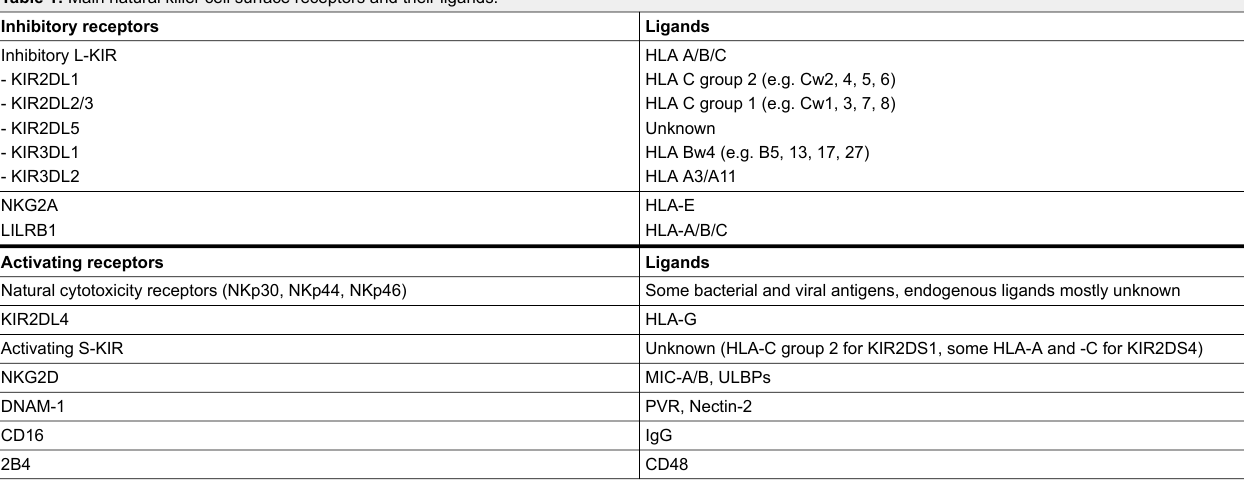
Table 1: Main natural killer cell surface receptors and their ligands. Inhibitory